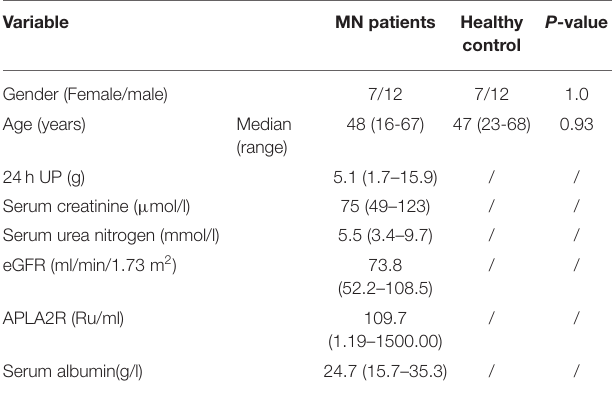
TABLE 1 | Summary of clinical and laboratory information of the recruited people.